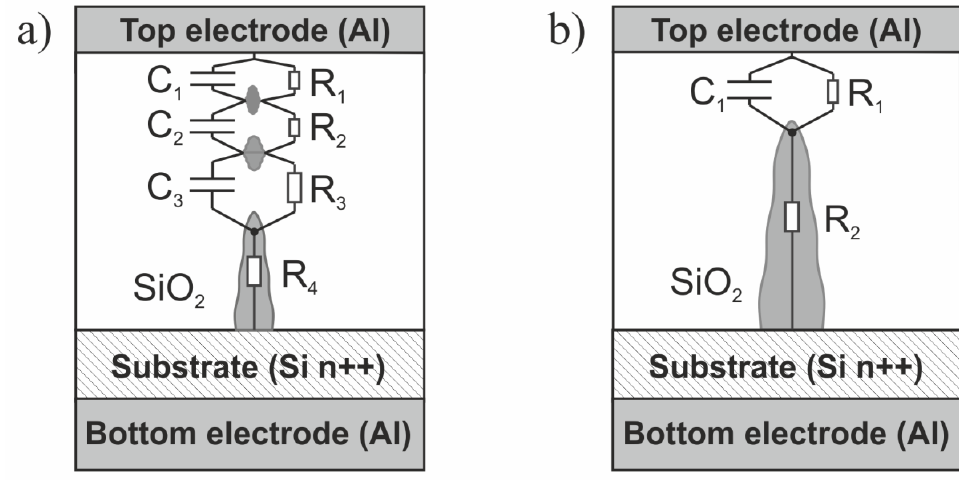
Figure 11. The sketch of the RS structure and its electrical model in HRS ( a ) and LRS ( b ). The parallel depictions of the proposed equivalent circuits (at HRS and LRS for f = 100 kHz) consist of elements (G PM , C PM ) whose values correspond to the measured ones marked in Figure 6a,b—real and imaginary parts of admittance, respectively. Static